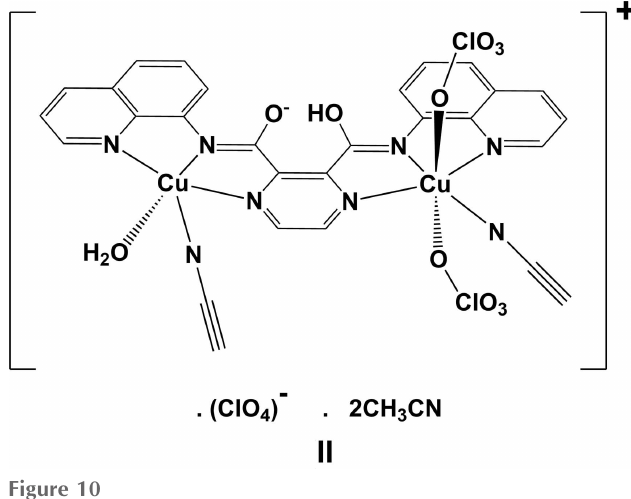
Figure 10 The structure of complex [(H 2 O)Cu 2 (HL1 (cid:4) )(ClO 4 ) 2 (CH 3 CN)] (cid:3) (ClO 4 ) (cid:3) - 2(CH 3 CN) ( II